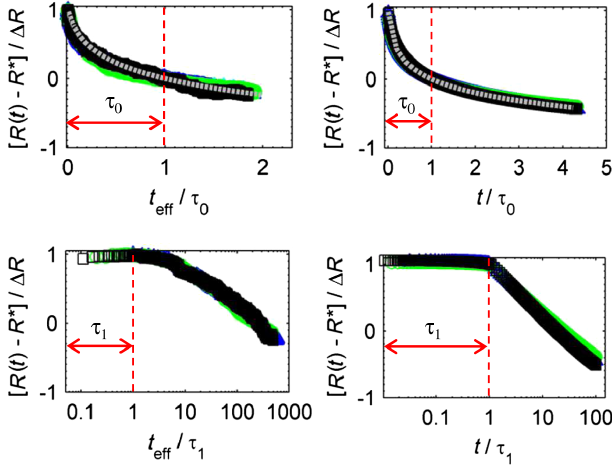
FIG. 5. Scaled curves of the R ð t Þ data sets of Fig. 4. The left panels show the collapsed experimental data and the right ones the numerical simulations. The time τ 0 is an auxiliary scaling variable, which is proportional to the characteristic time τ 2 (see Appendix G for details on the scaling procedure). The scaled data were fitted (white dotted line) with a generalized version of Eq. (8) (see Appendix G). The lower panels show the same data sets scaled with the shock-wave impact time τ 1 . (The exper- imental curves show only three data sets for the lower current values. At higher currents, our electronics could not resolve τ 1 .) To achieve the scaling of the lower panels, we assumed for each plot the normalization value of Δ R determined from the previous scaling (top